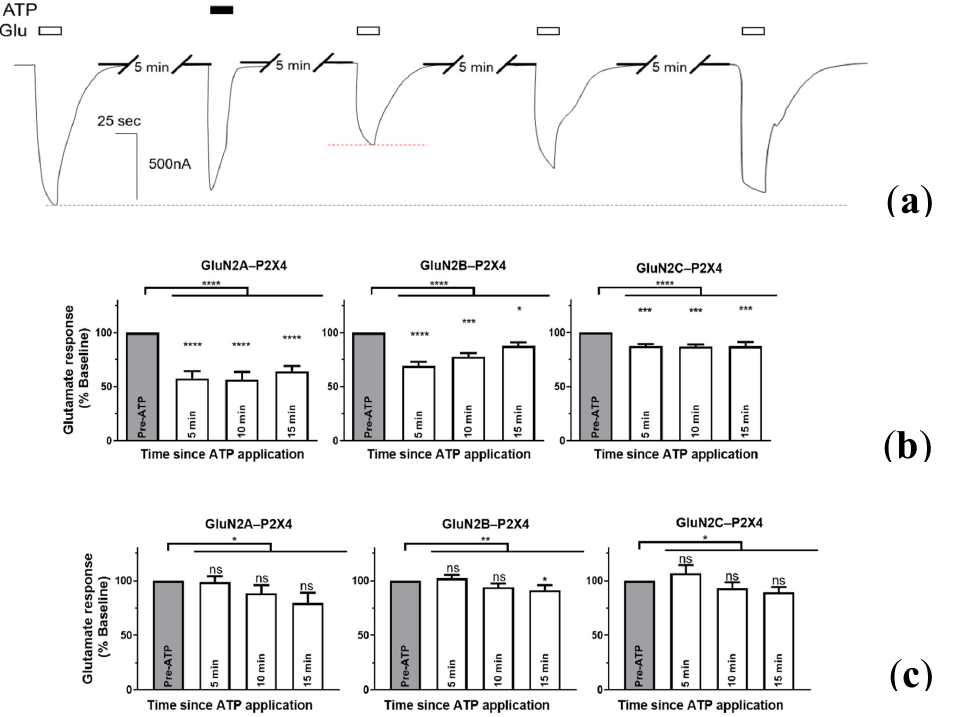
Figure 4. The time-course for recovery of P2X4-mediated NMDAR inhibition in the absence or presence of calcium. ( a ) Representative current evoked by application of Glu (2 µ M), before and after activation of P2X4 by ATP (5 µ M), from an individual oocyte coexpressing GluN2B-containing NMDARs and P2X4 in the absence of calcium (CfRS). Bar graphs representing the mean of the amplitude of NMDARs responses to Glu before and after P2X4 activation by ATP, either in the absence ( b ) or presence ( c ) of calcium. All values were normalized to the Glu response obtained before P2X4 stimulation. Glu responses after P2X4 activation were significantly lower NMDARs containing each of the GluN2A-C subunits in